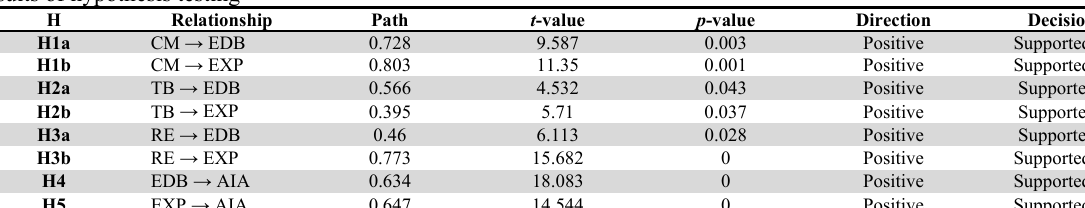
Results of hypothesis testing